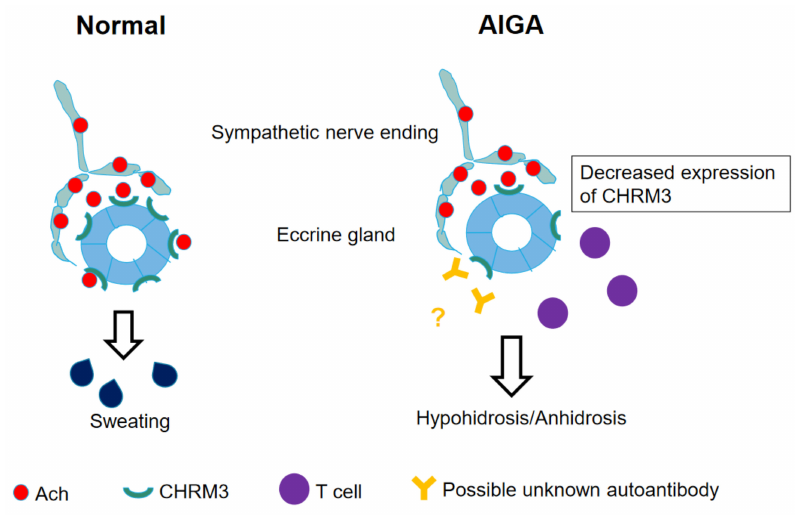
Figure 2. Summary of the immune mechanisms underlying